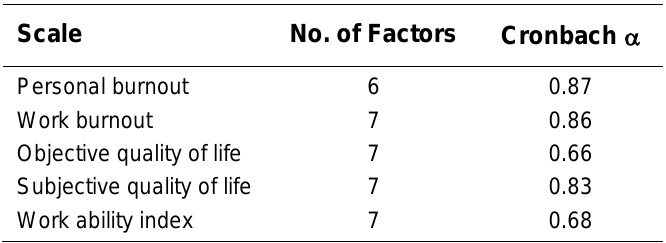
Reliability Analysis for Measuring Burnout, Quality of